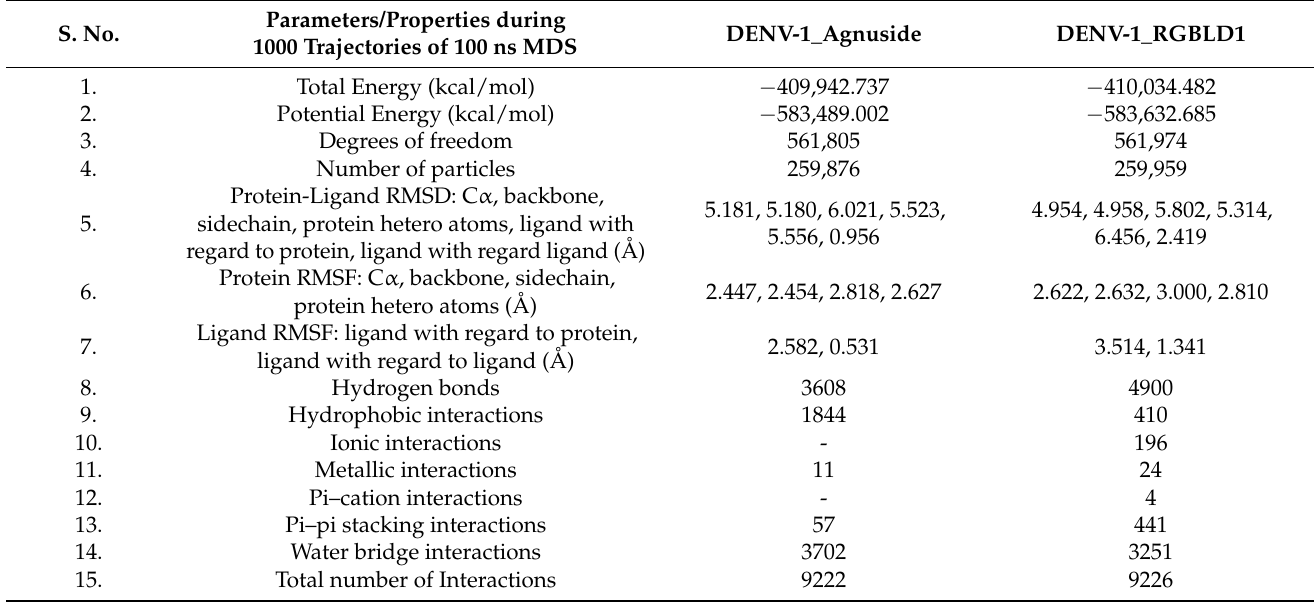
Table 6. Comparison of scores obtained in the molecular dynamic’s simulation parameters for DENV-1 reference molecule and novel analog molecule.